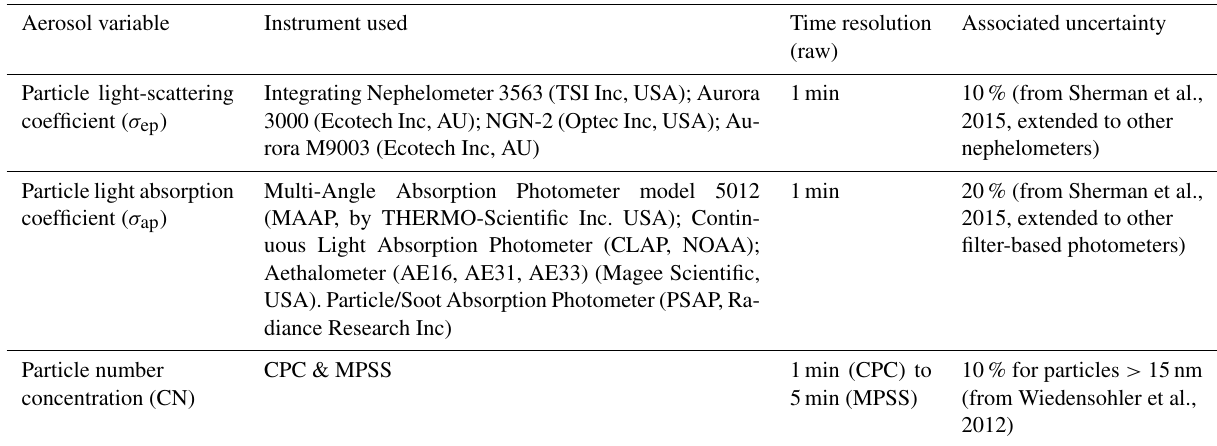
Table 2. Instruments used for the determination of aerosol optical and physical properties in SARGAN, original time resolution for raw data, and associated